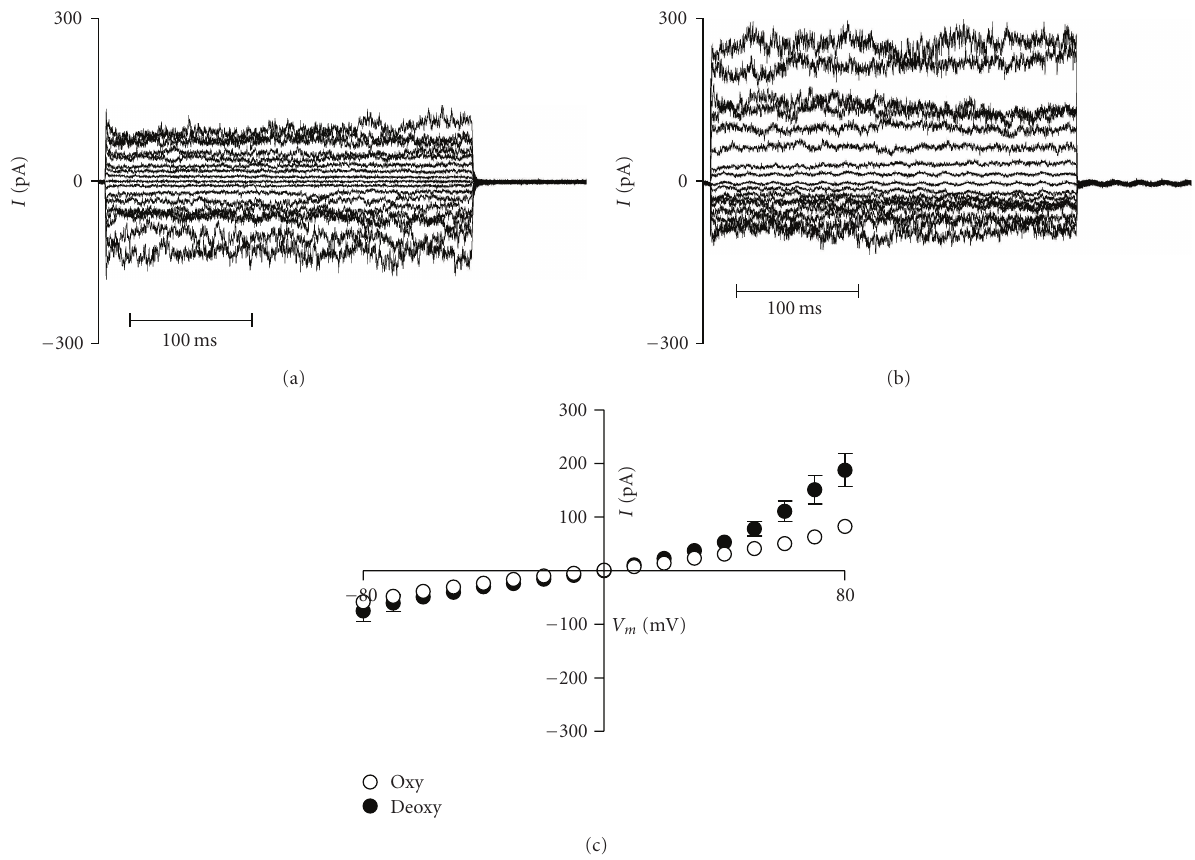
Figure 4: Conductance of red blood cells (RBCs) from sickle cell patients heterozygous for HbS and HbC (HbSC genotype). (a), (b) Representative whole-cell recordings from (a) oxygenated and (b) deoxygenated RBCs. (c) Mean whole-cell currents + S.E.M., n = 5. Test potentials from − 80 to +80mV were applied for 300 ms in 10mV increments from a holding potential of − 10 mV. Measurements were made using Na + -containing bath and pipette solutions. Data taken from [20]. See [66] for experimental details. The conductance of RBCs from HbSC patients is high and increases further on